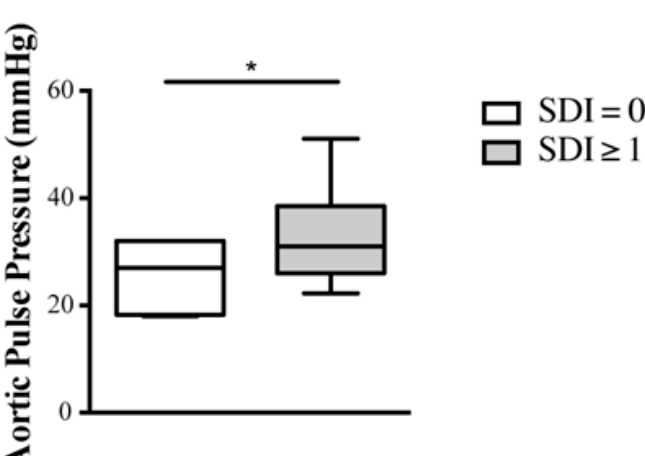
Figure 2. Box plots of AoPP in SLE patients with and without organ damage. Patients with organ damage, defined by a SDI score ≥ 1, showed significantly higher values of AoPP than those without no organ damage (32 (9) vs. 28 (7), * p = 0.03). List of abbreviations: SLE, systemic lupus erythematosus; SDI, Systemic Lupus International Collaborating Clinics / American College of Rheumatology Damage Index. Table 4. Multiregression analysis between markers of arterial sti ff ness and clinical and laboratory AIx@75 showed positive correlation with age (r = 0.57; p < 0.001), negative correlation with parameters in SLE